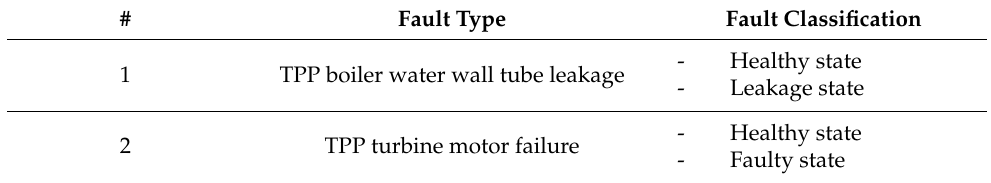
Table 2. Description of fault case